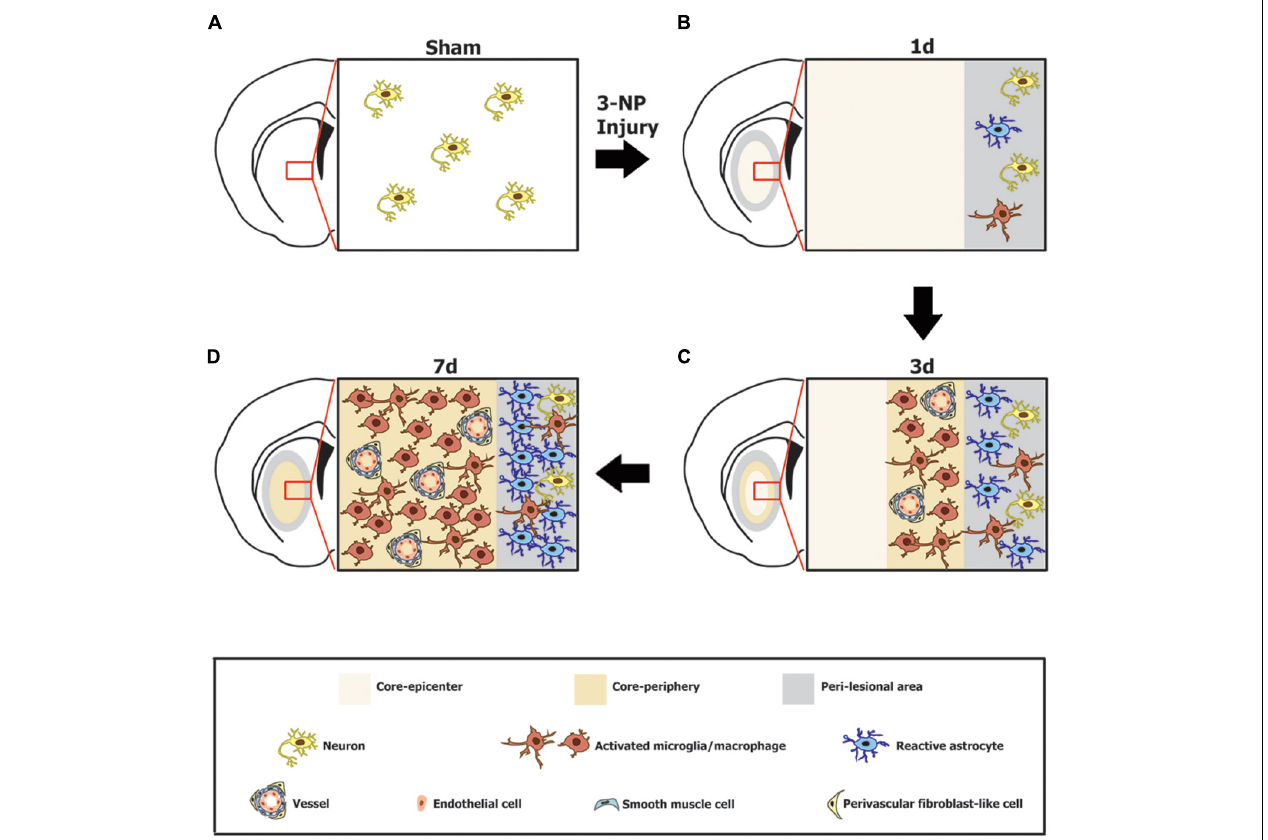
FIGURE 9 | Schematic representation of the phenotypic heterogeneity of GRP78-positive cells in the lesion core and perilesional area in the striata after lesion induction using 3-nitropropionic acid injection. (A) In the saline-treated control striatum, GRP78 immunoreactivity is almost exclusively localized to striatal neurons. (B) One day after 3-NP injection, neuronal profiles are absent from the lesion core, while neurons in the peri-lesional area show evident GRP78 immunoreactivity. In addition, astrocytes and microglia in the peri-lesional area show very weak immunoreactivity for GRP78. (C) Three days after lesion induction, GRP78 expression is induced in association with activated microglia/macrophages and the vascular wall, including endothelial cells, smooth muscle cells, and adventitial fibroblast-like cells in the lesion periphery, although these cell types are absent from the lesion epicenter. In addition, evident GRP78 immunoreactivity is observed in reactive astrocytes and activated microglia in the perilesional area. (D) Seven days after lesion induction, intense GRP78 expression is observed in the vascular profiles and in activated microglia/macrophages throughout the lesion core. In addition, intense GRP78 expression is observed in reactive astrocytes and activated microglia in the peri-lesional